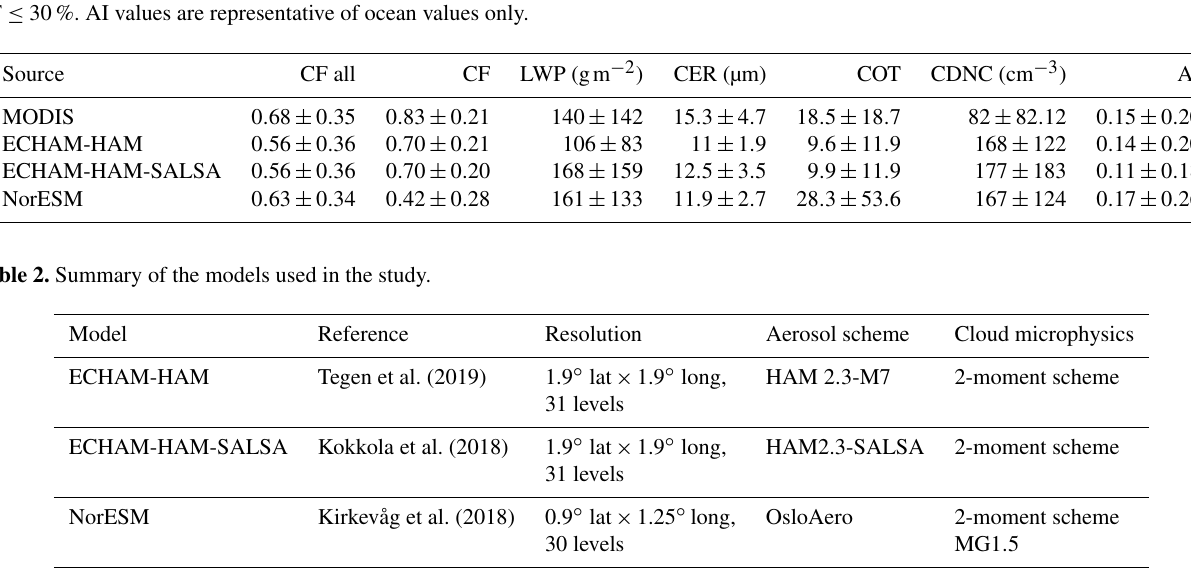
Table 1. Annual global in-cloud mean value ± standard deviation for the parameters used in the study. If a grid point has CF ≤ 30%, the point is set to fill values in all the datasets. The process leads to a 35% reduction in data points in each dataset. “CF all” is not screened for CF ≤ 30%. AI values are representative of ocean values only.